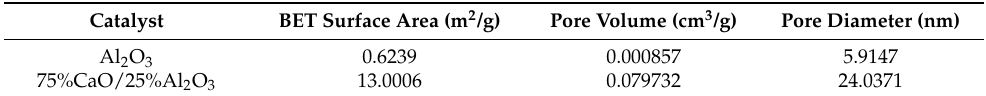
Table 2. Textural properties and surface area analysis.